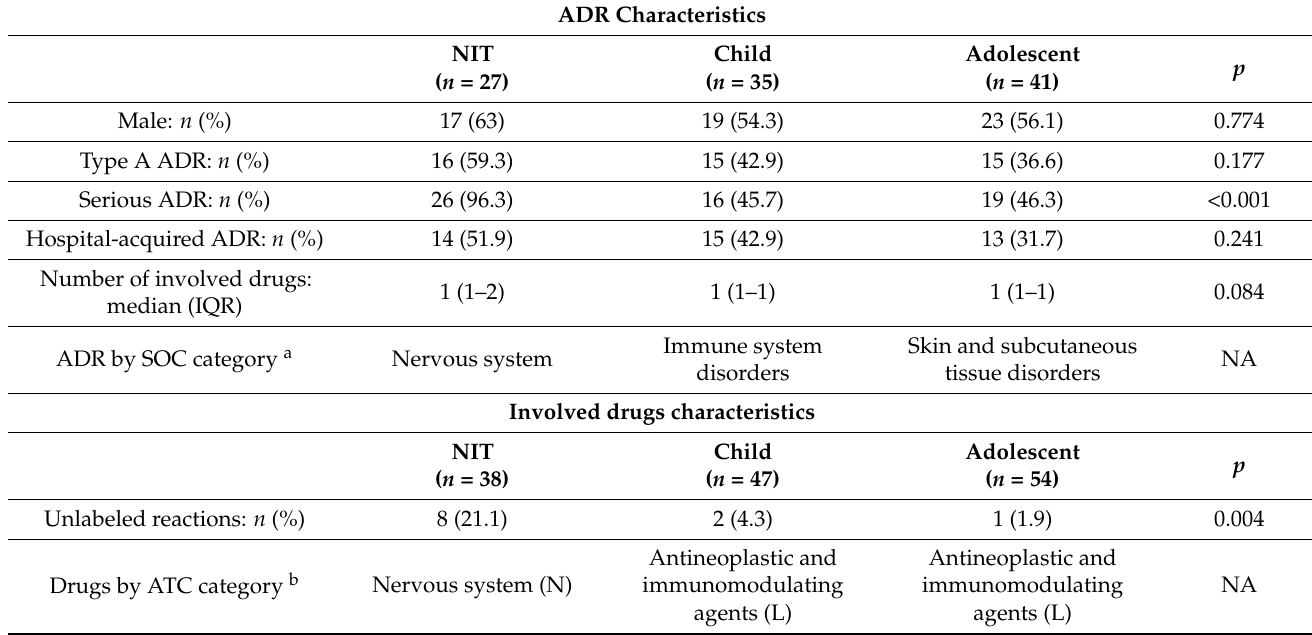
Table 5. Comparison of adverse drug reactions (ADR) by patient age